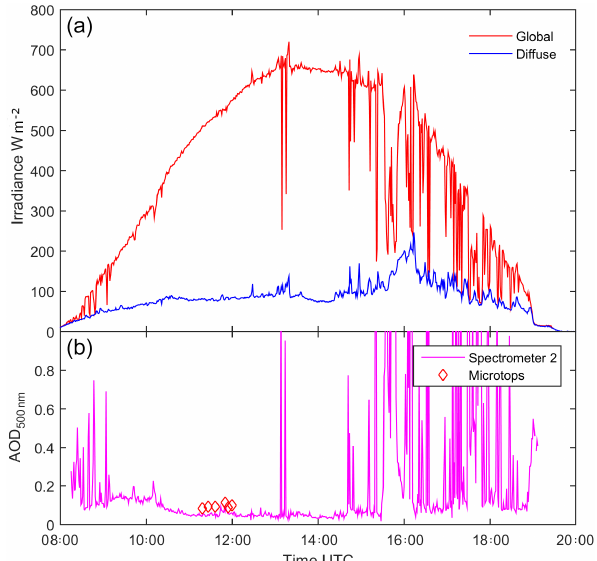
Figure 11. Spectrally resolved outputs for a single reading (12:00 on 4 October 2014). I G and I D spectra (a) , and optical depth (b) . Total optical depth (OD) and OD with the Rayleigh component re- moved are shown, with Microtops aerosol optical depth (AOD) val- ues superimposed. Gaseous absorption features at certain windows have not been